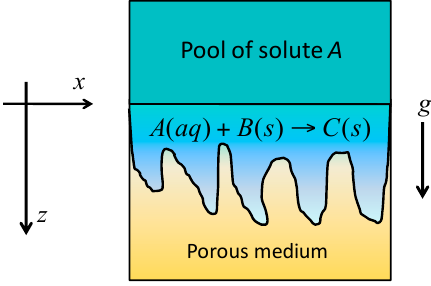
Figure 1. Solute A dissolves in the underlying fluid, forming a diffusive boundary layer. Dissolution enhances the local density difference between the solute-saturated fluid at the interface and the underlying pure fluid, driving finger formation and convection. Dissolved solute A reacts with reactant species B in the host rock, forming product C , which precipitates out from the fluid. Chemical reaction alters the spatial distribution of the solute and thereby changes the density